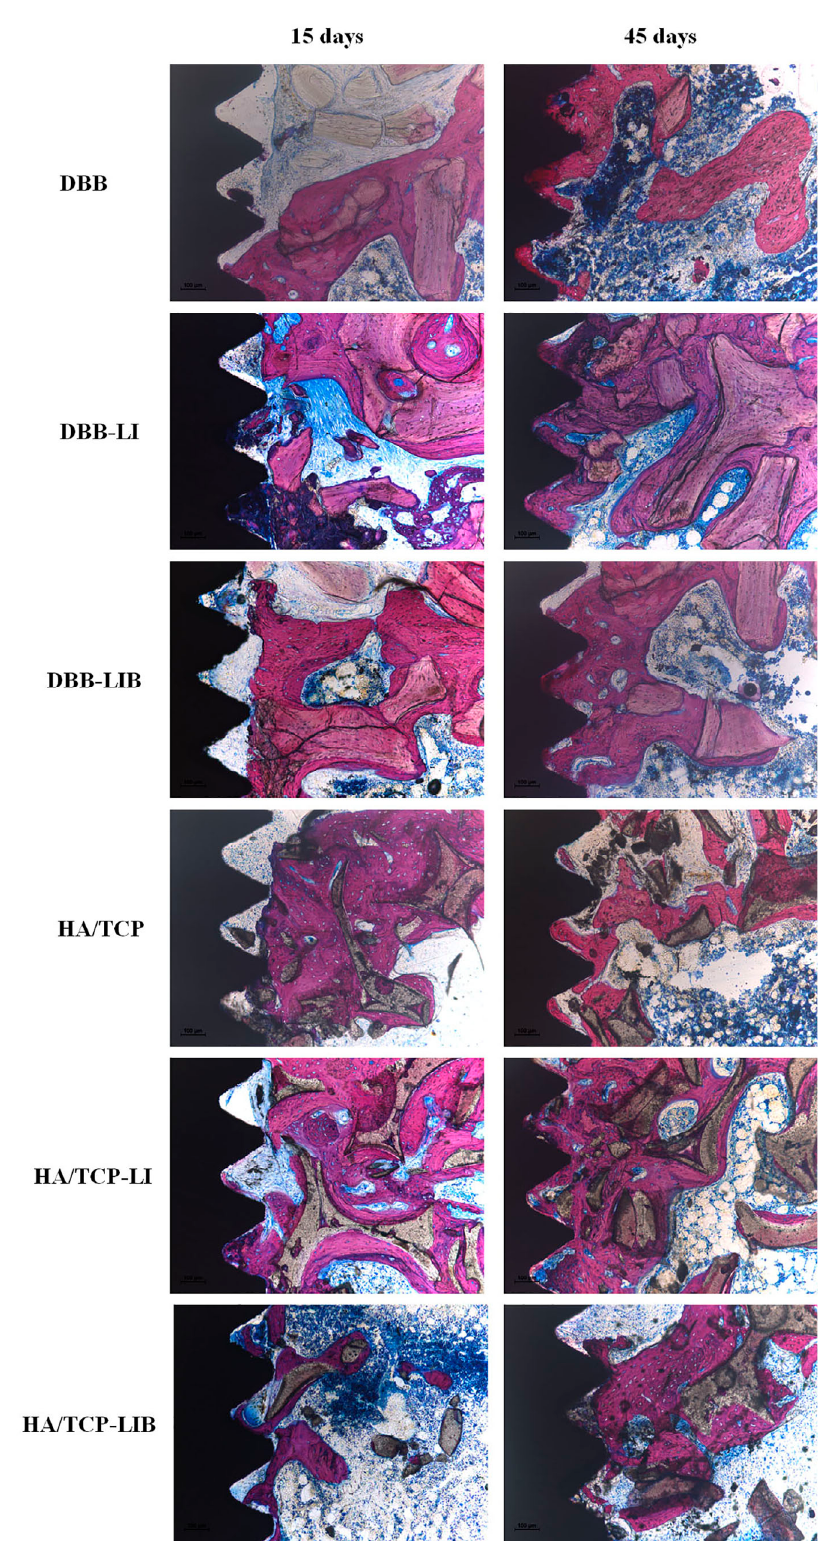
Figure 5- Representative images of non-decalcified histological sections of each group showing the presence of bone substitutes attached to the implant surfaces through a bridge of neoformed bone tissue (Stevenel’s blue and acid fuchsin-100x